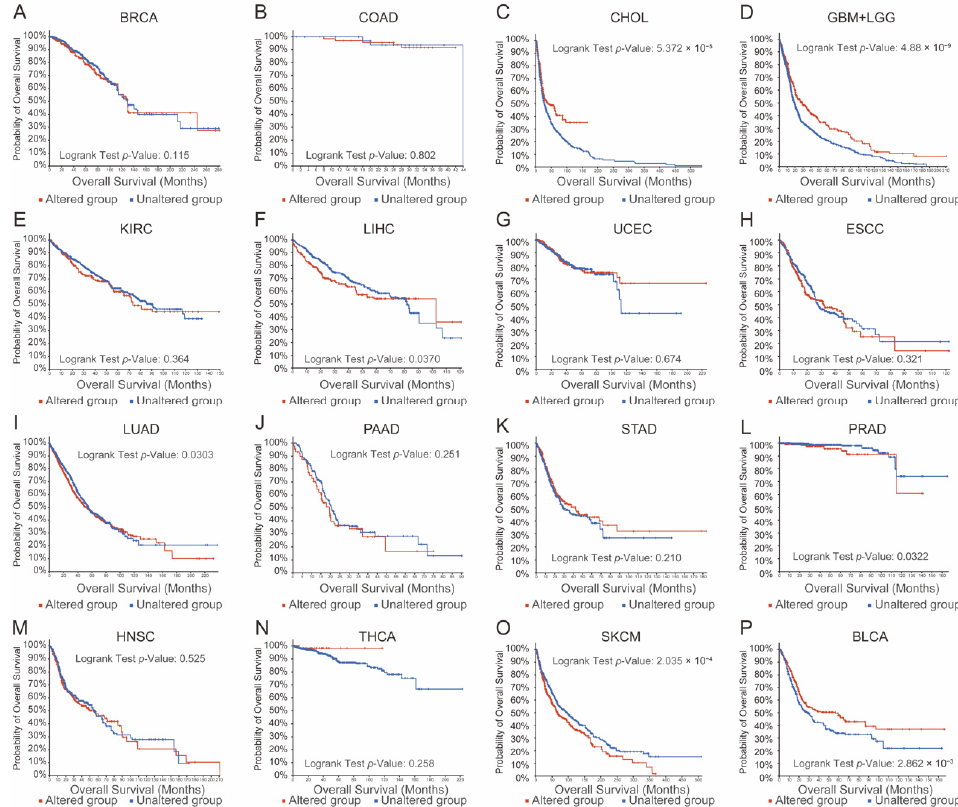
Figure 1. Human cancer prognosis was related to aberrations of genes of the TRP family genes. ( A – P ) The relationship between TRPs family genes aberrations and overall survival time in patients with breast cancer, colon cancer, cholangiocarcinoma, glioma, kidney cancer, liver cancer, uterus corpus endometrial carcinoma, esophageal cancer, lung cancer, pancreatic cancer, stomach cancer, prostate cancer, head and neck cancer, thyroid cancer, skin cancer, and bladder cancer.